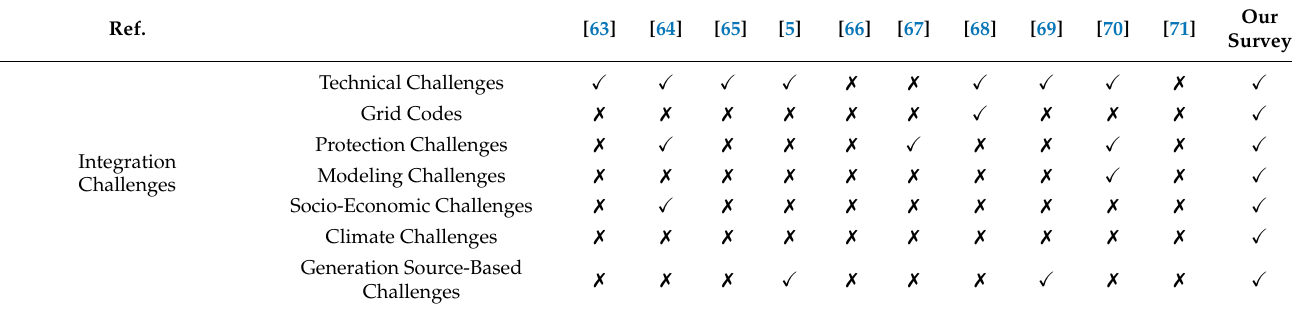
Table 2. Comparison of this paper’s review with reviews of other literature.